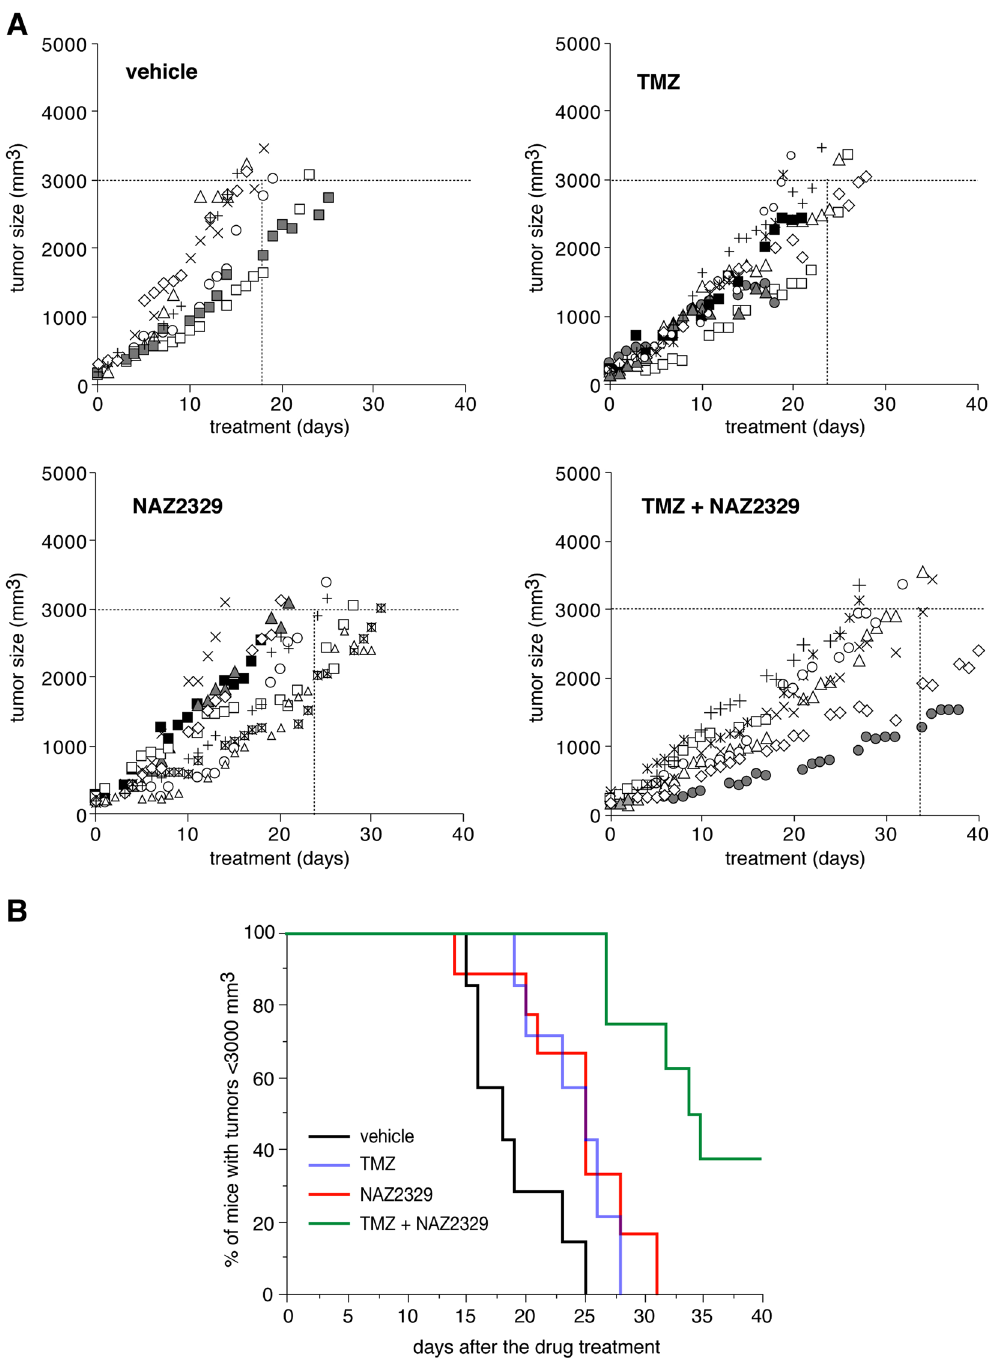
Figure 10. Antitumor effects of NAZ2329 on the C6 mouse xenograft model. ( A ) Nude mice were subcutaneously implanted with C6 cells (5 × 10 6 cells), and tumor size was monitored until the criteria were met ( > 150 mm 3 ). At this time, mice were randomly divided into 4 treatment groups. DMSO as the vehicle control ( n = 7), NAZ2329 (45 µ mol (22.5 mg)/kg body weight, n = 9), temozolomide (TMZ, 50 mg/kg, n = 9), and the combination of NAZ2329 (45 µ mol/kg) with TMZ (50 mg/kg) ( n = 9) were administered intraperitoneally twice per week until the humane endpoint ( > 3,000 mm 3 tumor size or 40 days after the treatment). Tumor growth in each animal and the number of days required to reach a tumor volume of 3,000 mm 3 are shown in the graph. Five mice were sacrificed due to tumor necrosis (shown by gray symbols in the graph), and two mice unexpectedly died suddenly during the observation period (black symbols in the graph). ( B ) A Kaplan-Meier analysis of the four treatment groups shown in A . Significant differences were observed in the days until the tumor volume reached 3,000 mm 3 between the vehicle vs NAZ2329/TMZ ( P < 0.05), NAZ2329 vs NAZ2329/ TMZ ( P < 0.05) and TMZ vs NAZ2329/TMZ ( P < 0.05) (Kruskal-Wallis test followed by Steel-Dwass